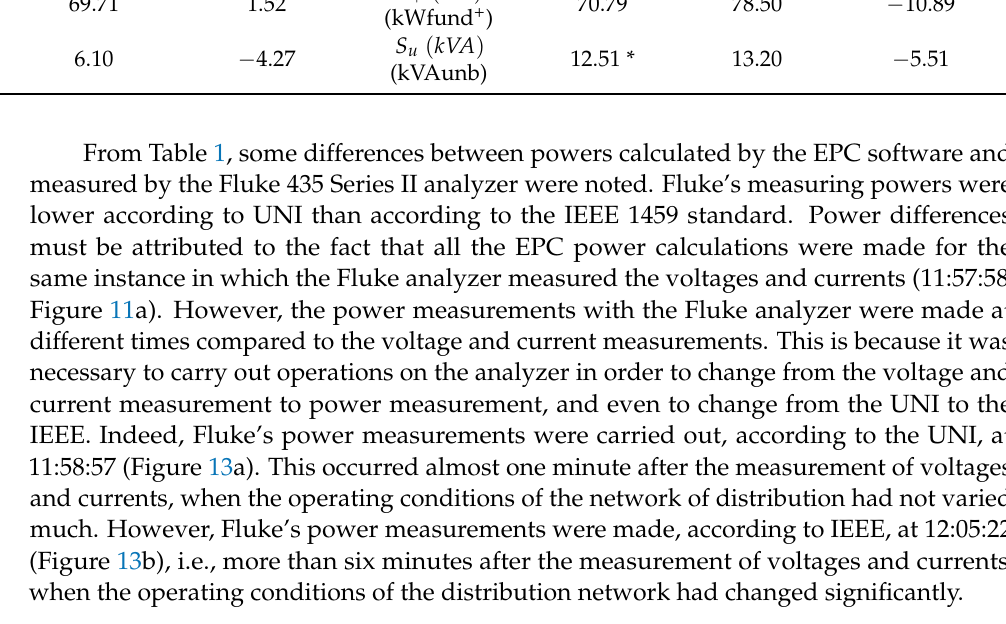
Table 1. Summary of powers calculated by the EPC software and measured by the Fluke 435 Series II analyzer and their comparison. (*) determined according to S u , IEEE =